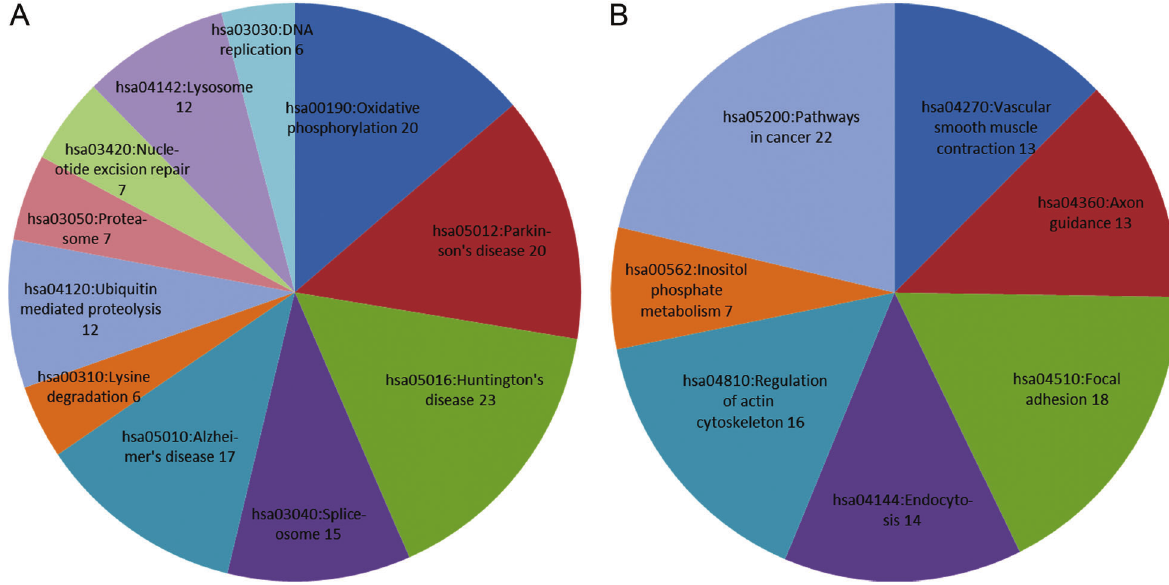
Figure 1. KEGG pathway enrichment analysis for upregulated differentially expressed genes ( A ) and downregulated differentially expressed genes ( B